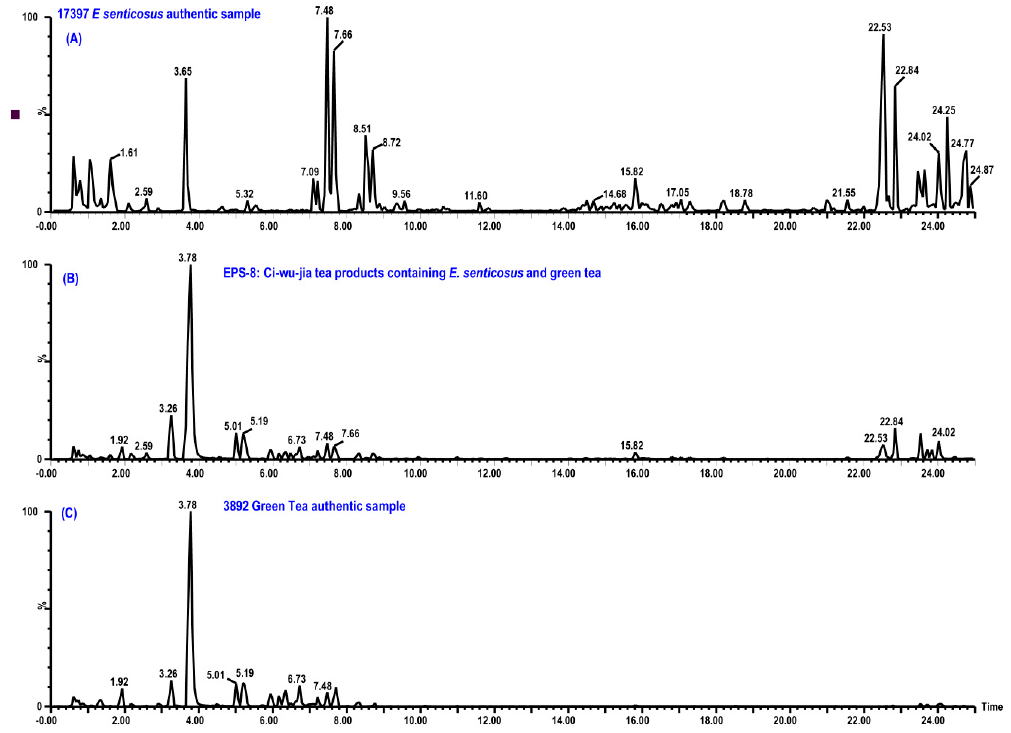
Figure 5. Chromatograms of #17397 E. senticosus authentic plant sample ( A ), typical Ci-wu-jia tea product (EPS-8) containing E. senticosus and green tea ( B ), and #3892 green tea authentic plant sample ( C ).